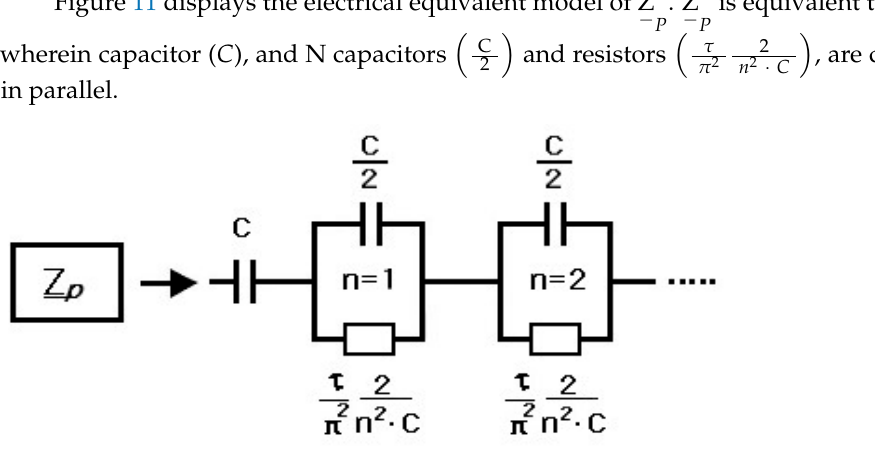
Figure 11. Electrical equivalent model of the supercapacitor impedance ( Ẕ (cid:3017) ) [6].